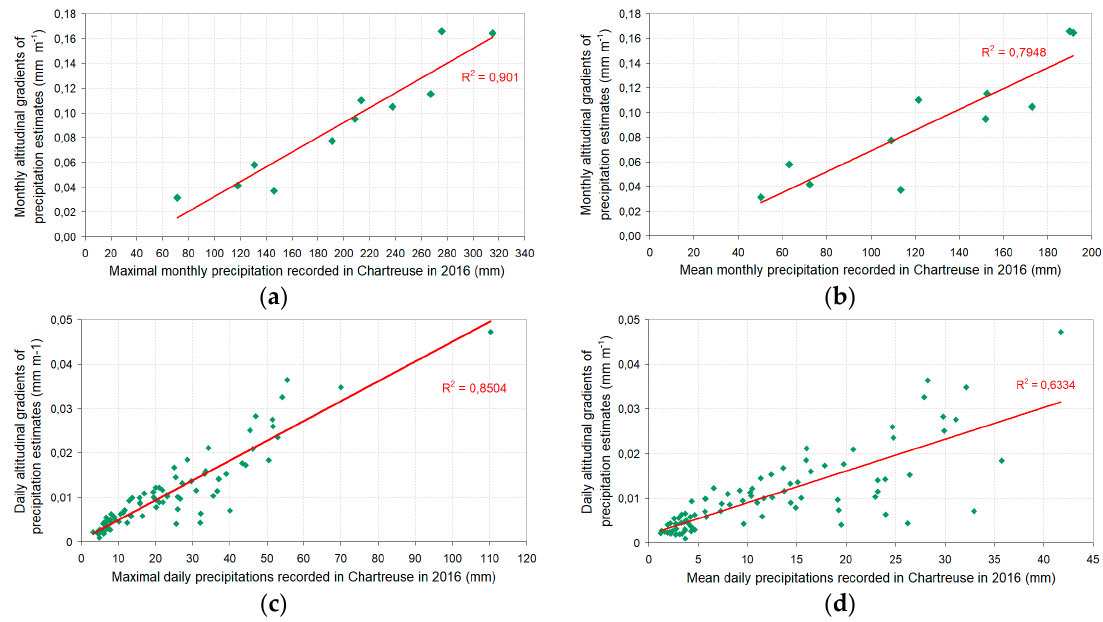
Figure 5. Relation between altitudinal gradient estimates and magnitude of the precipitation, for the Chartreuse massif. ( a ) With the maximal monthly precipitation recorded; ( b ) with the mean monthly precipitation recorded; ( c ) with the maximal daily precipitation recorded; and ( d ) with the mean daily precipitation recorded. For daily precipitation, only significant gradients have been used.